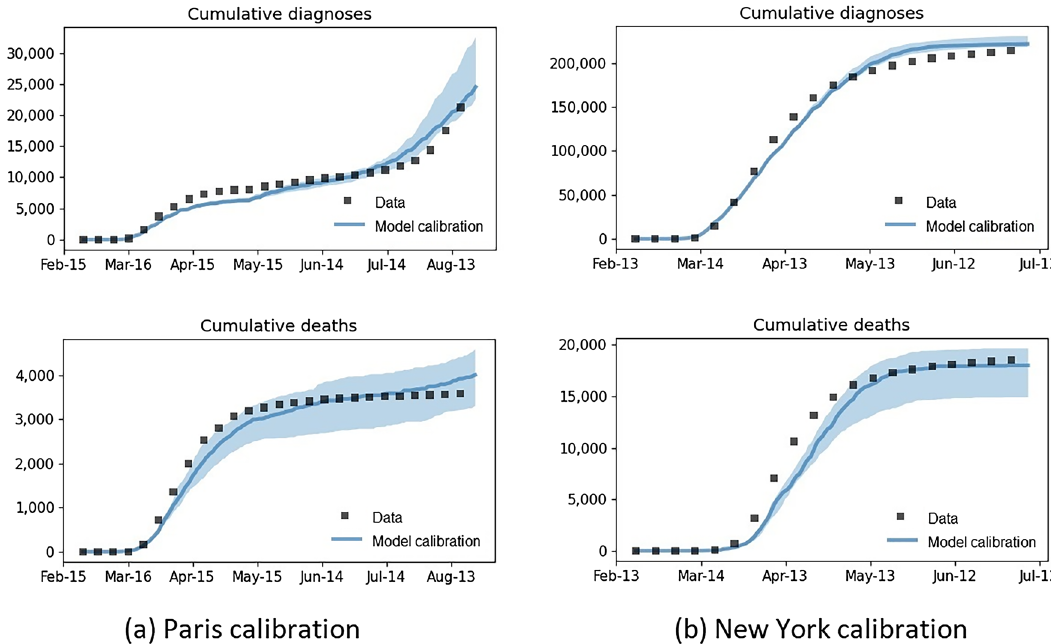
Figure 1. Calibration of ( a ) Paris to data from February 25 to August 24, 2020, and ( b ) New York to data from February 20 to July 7, 2020. Calibration data are shown in black, median model projection in blue, and the blue shaded area represents the 80% uncertainty